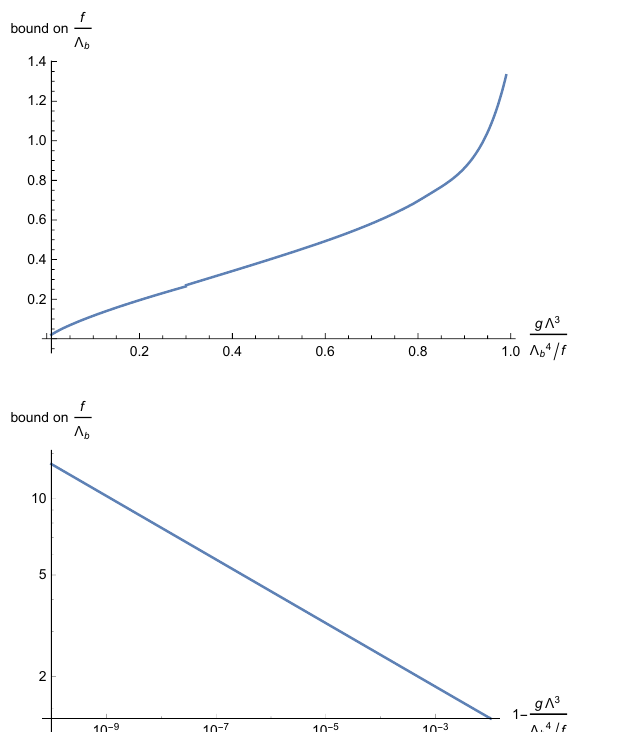
Figure 12 . The lowerbound on f= (cid:3) b as a function of (cid:20) lowerbound on f= (cid:3) b for (cid:20)